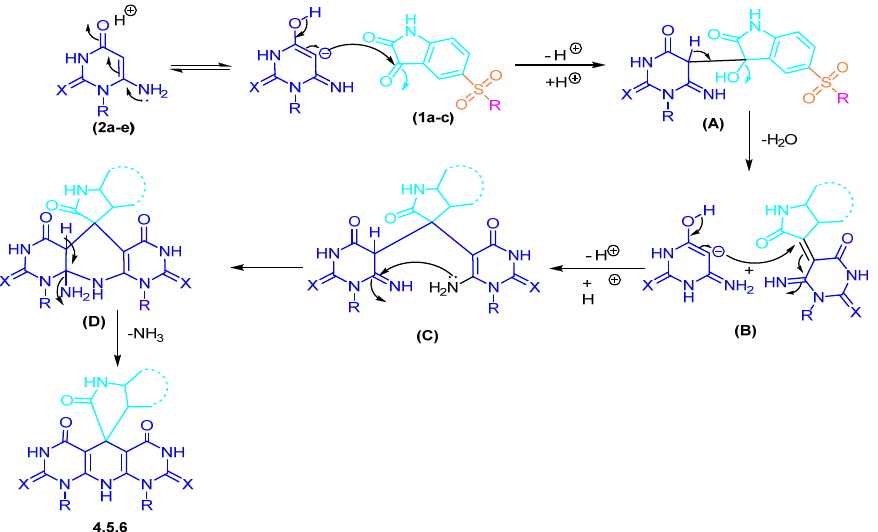
Scheme 2. Illustration of the proposed mechanism for synthesis of spiro–oxindole